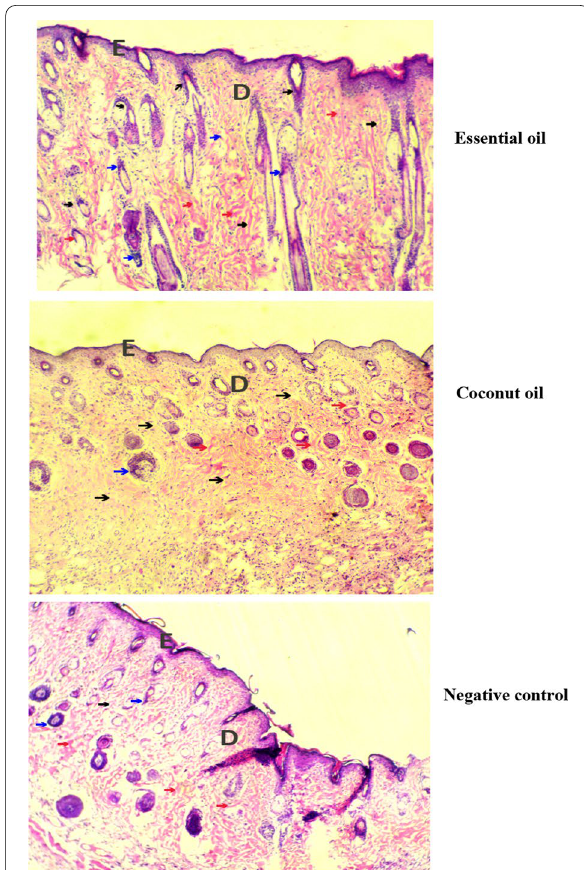
Fig. 6 Photomicrographs of wounded skin tissue stained with haematoxylin and eosin showing granulation at day 10 Note : Blue arrows indicate red blood cells, fibroblast cells and connective tissue are indicated by red arrows, and macrophages are indicated by black arrows. The letter E signifies epidermis development. The portion of the dermis is denoted by the letter